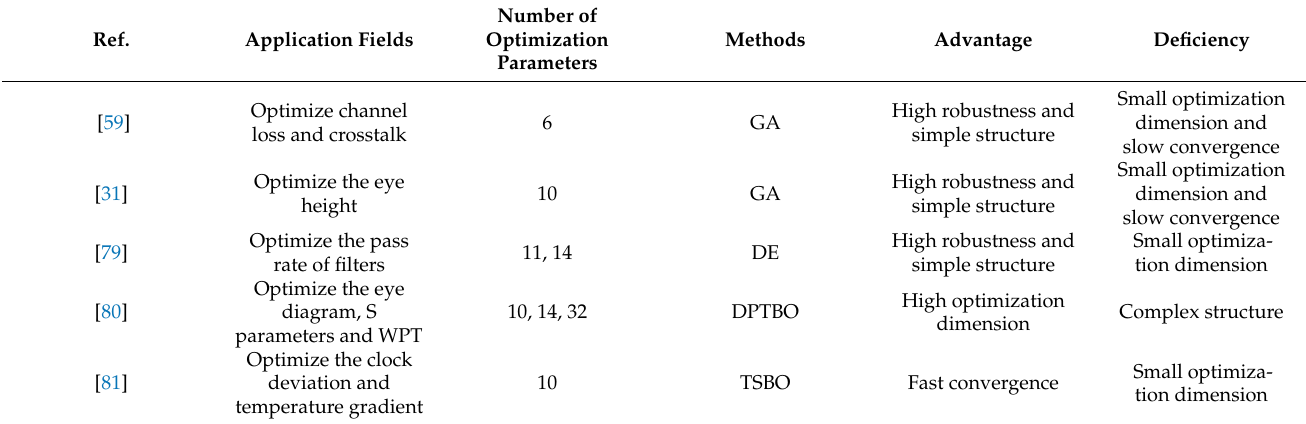
Table 2. Comparison of SI optimization algorithms.